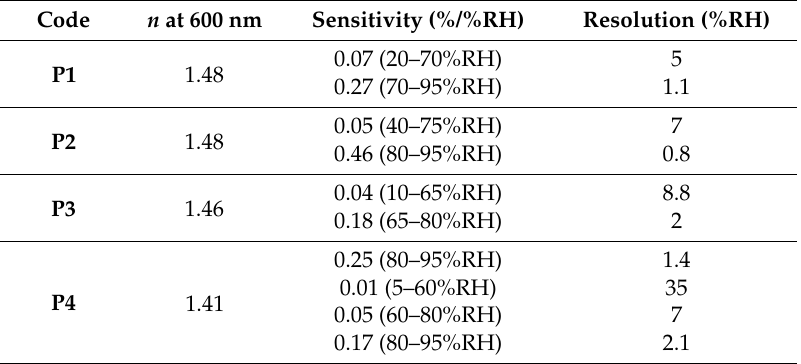
Table 2. Refractive index ( n ), sensitivity and resolution of thin films of P1–P4 polymers.